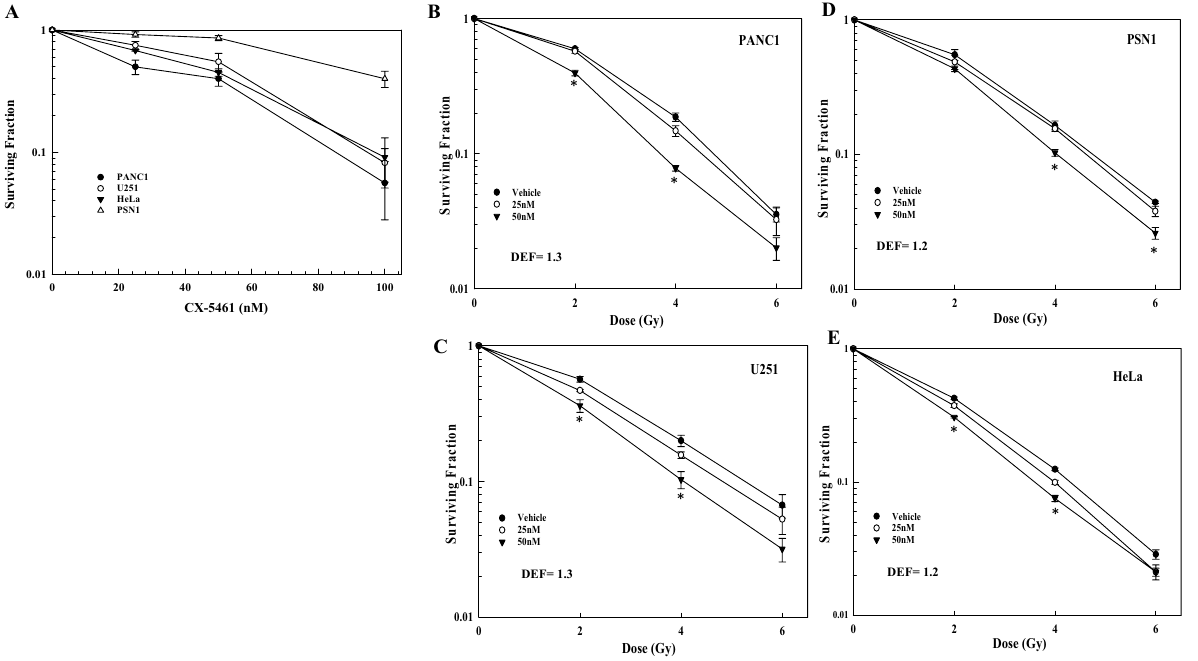
Figure 1. Tumor cell sensitivity to CX-5461 and the effects of CX-5461on radiosensitivity. (A) Tumor cell lines were treated with CX-5461 (25–100 nM); after 24 h drug containing media was removed and replaced with drug-free media, and colonies determined after 10–14 days. To determine the effects of CX-5461 on radiosensitivity (B–E) drug was added to cell culture media 1 h before irradiation. 24 h post-irradiation, drug containing media was removed and replaced with drug-free media, and colonies determined after 10–14 days. Dose enhancement factors (DEFs) were calculated at a surviving fraction of 0.1. Values represent the mean ± SEM for three to four independent experiments. * p < 0.05 by Student’s